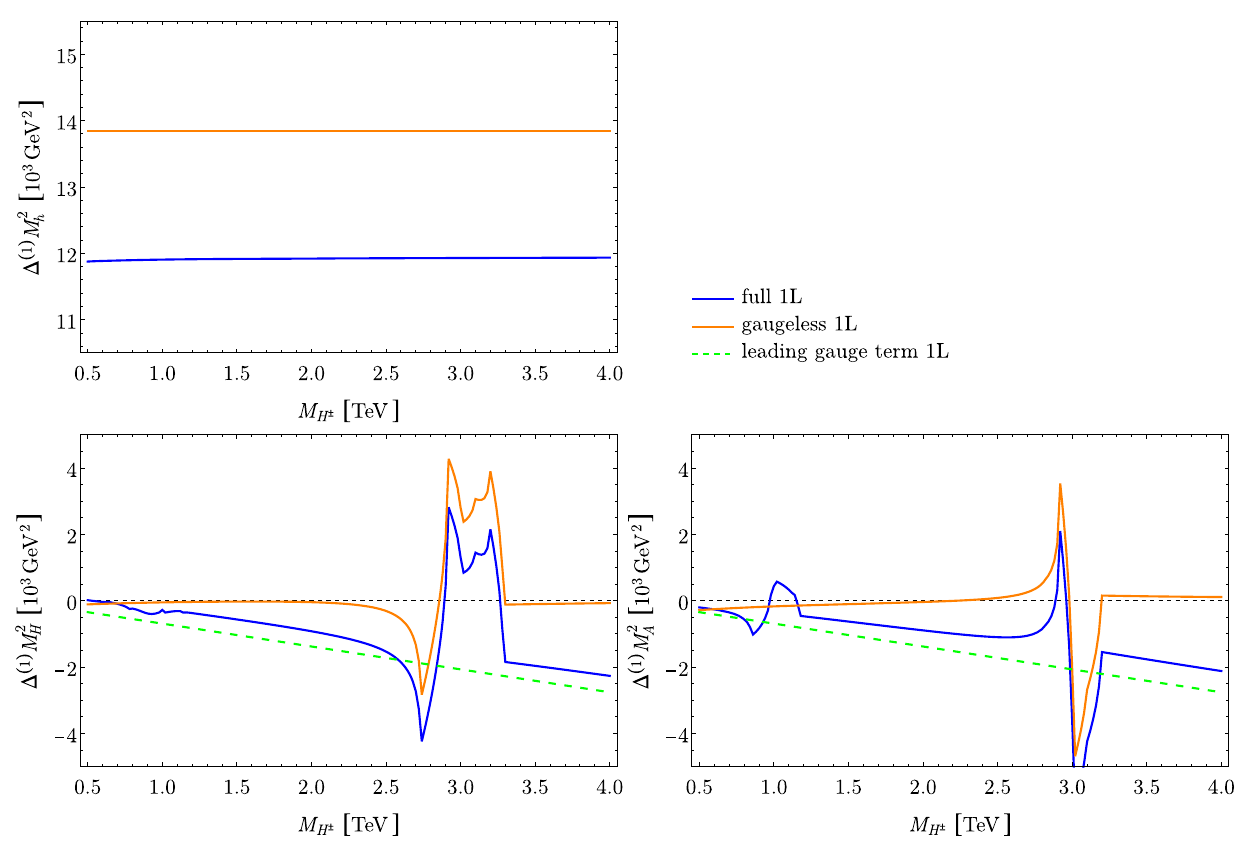
Fig. 1 Mass shifts at 1L for the neutral Higgs states. The full 1L effect is shown in blue and the corresponding result in the gaugeless limit in orange. For the heavy states (lower row), the leading contribution from gauge loops, scaling linearly with the Higgs mass, is presented in dashed